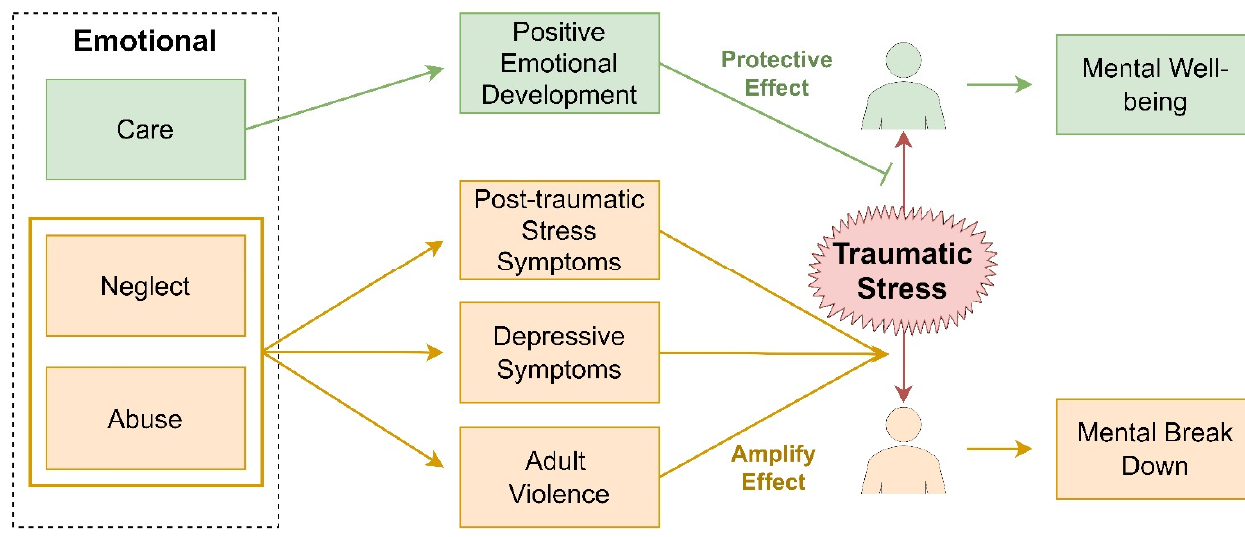
Figure 1. The impact of emotional care, emotional neglect, or abuse in early life on mental health in response to traumatic stress later in